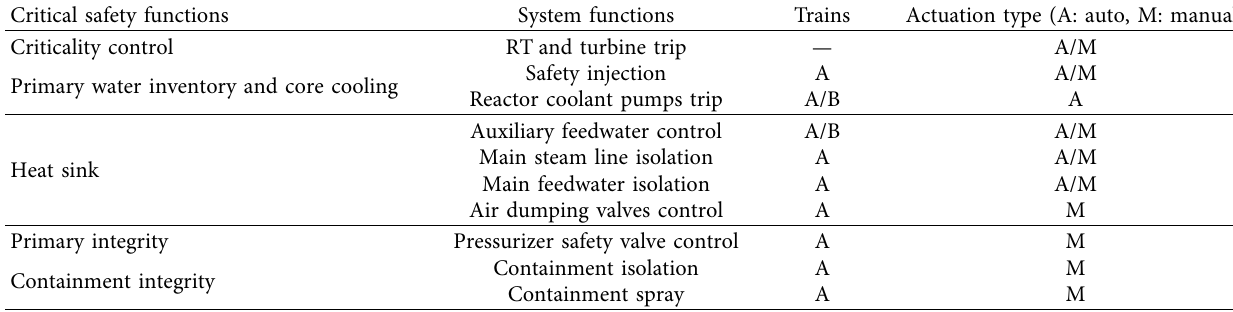
Table 1: Critical safety functions and actuation types on DAS.